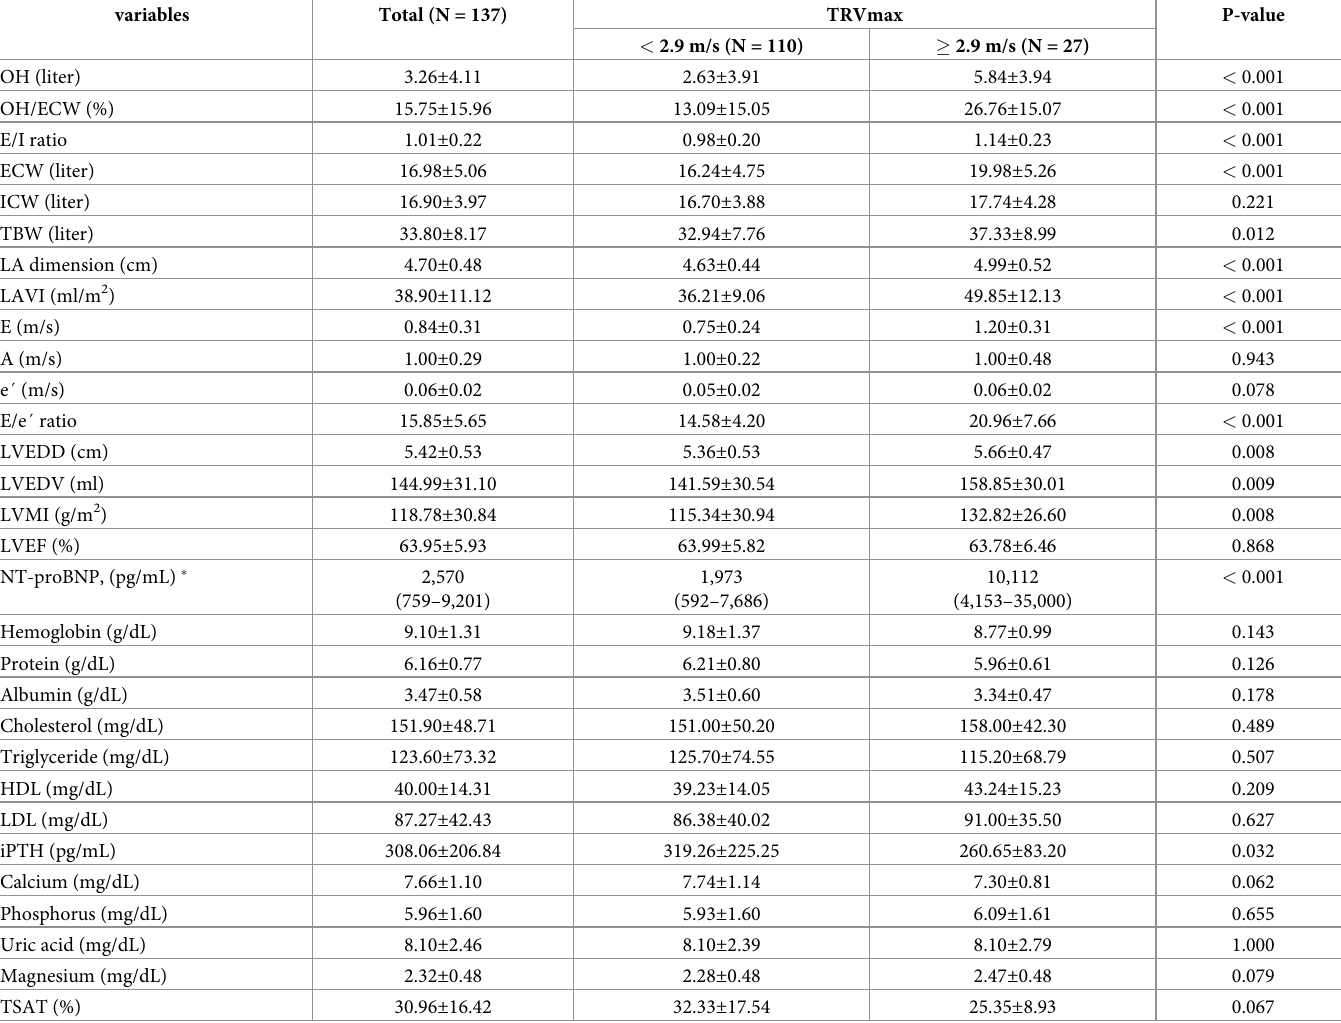
Table 2. Compared parameters (laboratory, bioimpedence and echocardiography) according to binary TRVmax.